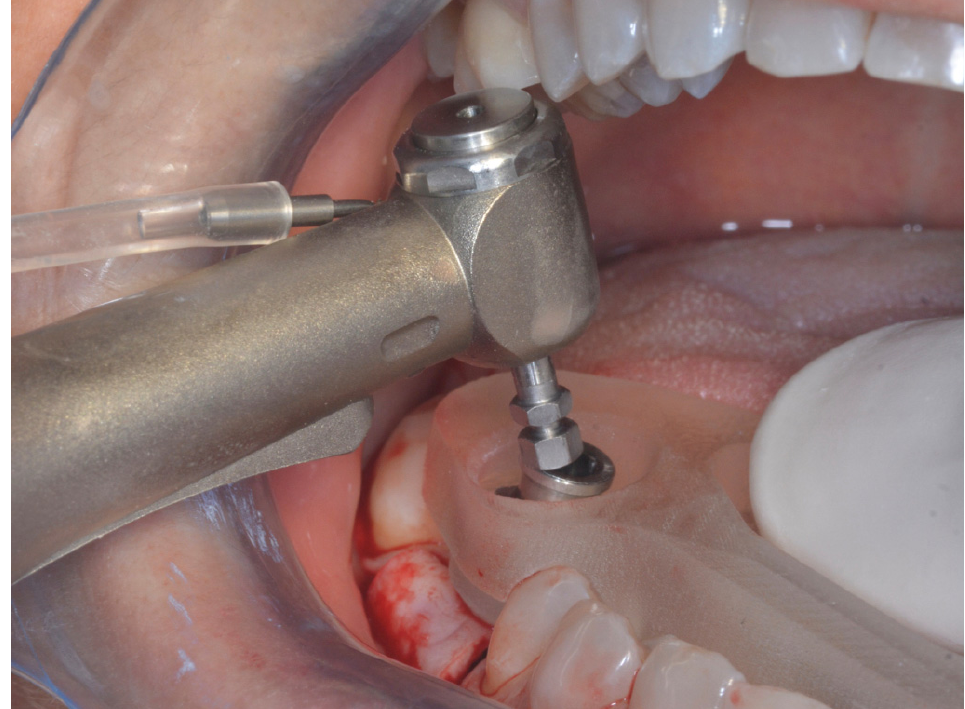
Figure 8. Intraoperative view of the unique hexagonal driver during the smart easy insertion procedure, showing the reduced inter-arch space that was needed by the innovative surgical kit.